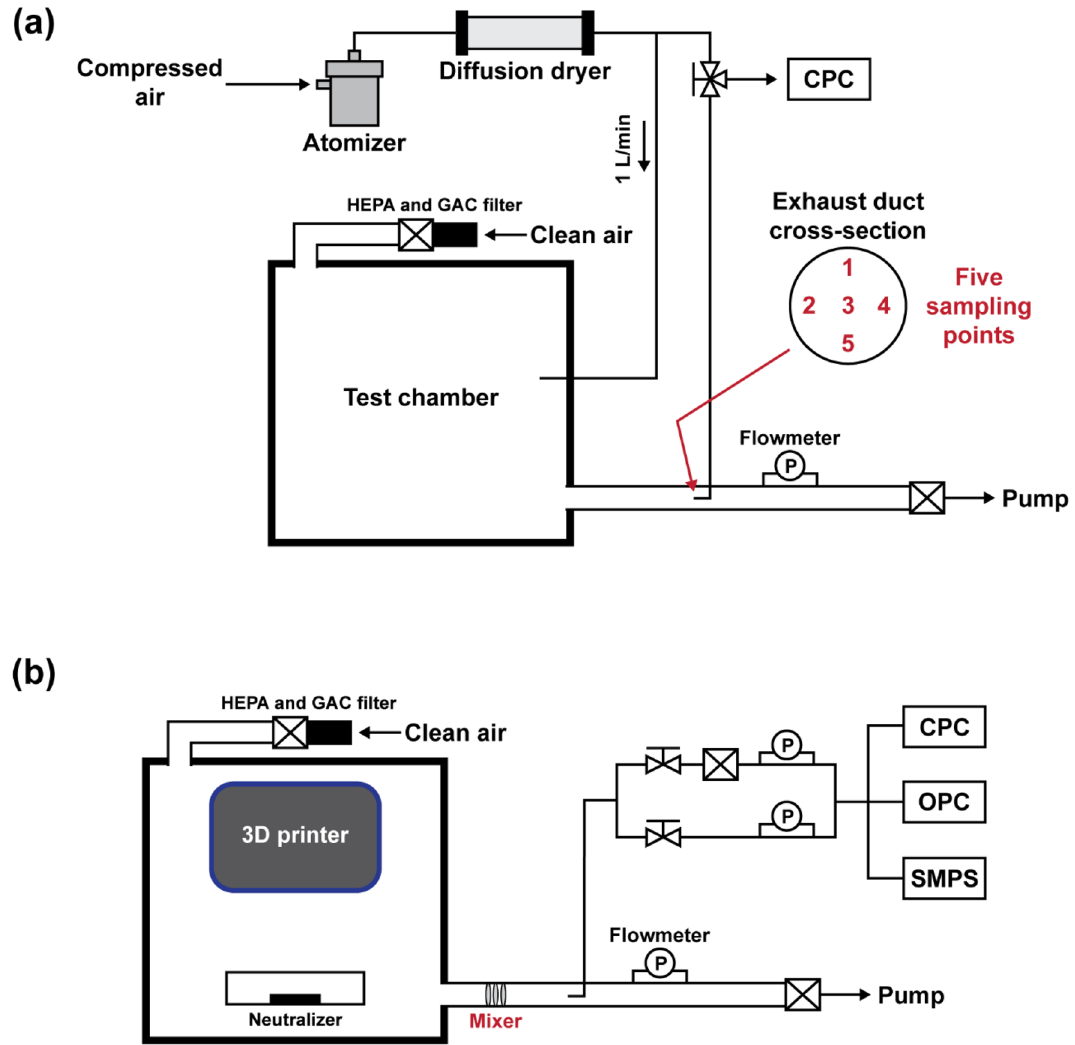
Figure 1. Experimental setups for ( a ) the performance test of mixers and (b) measurements of emissions from a 3D printer.